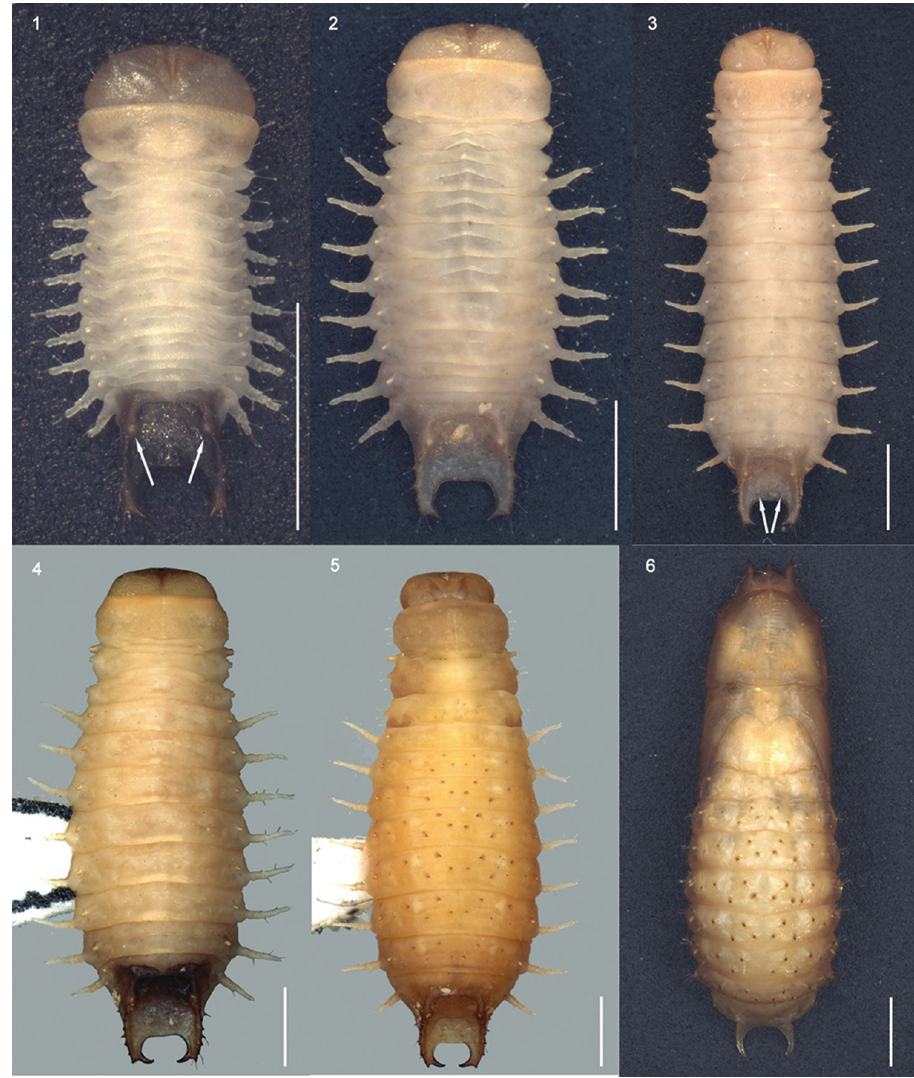
Figures 1–6. Octodonta nipae (Maulik) body dorsal view. 1 first instar (spiracles are indicated) 2 second instar 3 third instar (tubercles are arrowed) 4 fourth instar 5 prepupa 6 pupa. Scale bar: 1mm.